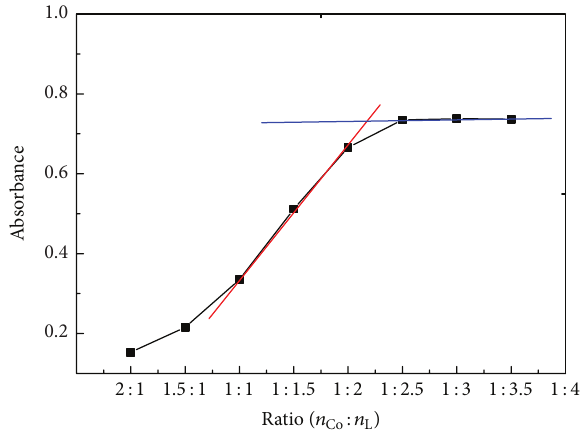
Figure 5: Proportions of the complexes determined by molar ratio